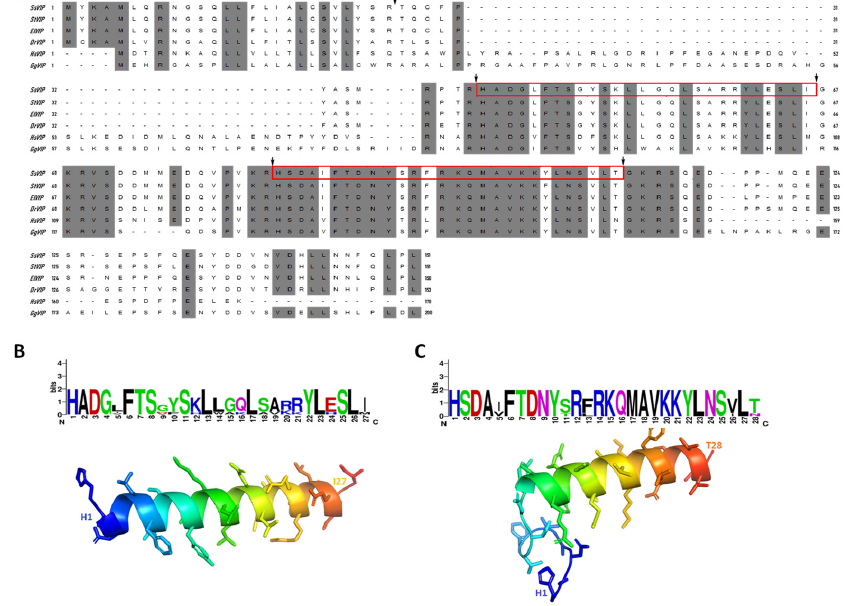
Figure 2. Characterization of prepro-vasointestinal (prepro-VIP) peptide of S. salar and secondary structure modeling of mature peptides. ( A ) Amino acid sequence alignment of prepro-VIP of teleost species and other vertebrates. The arrows indicate the putative protease cleavage, and red boxes indicate the peptide-histidine-isoleucine (PHI) and vasoactive intestinal peptide (VIP). ( B ) PyMOL generated the overlapping model based on PHI mature sequence. ( C ) PyMOL generated the overlapping model based on VIP mature sequence.